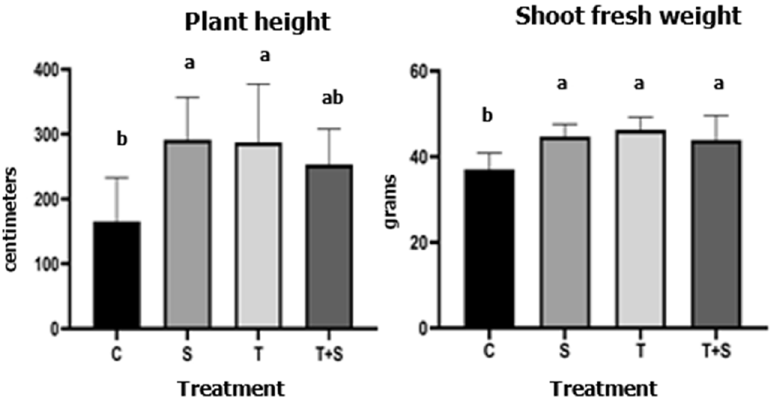
Figure 1. Variation of plant height ( left ) and shoot fresh weight ( right ) of parsley plants treated with Streptomyces fulvissimus AtB-42 (S), Trichoderma harzianum T22 (T), microbial consortium (S + T) and control group (C). Treatments with the same letter are not significantly different according to Tukey’s test ( p -value < 0.05). Error bars represent standard deviation.